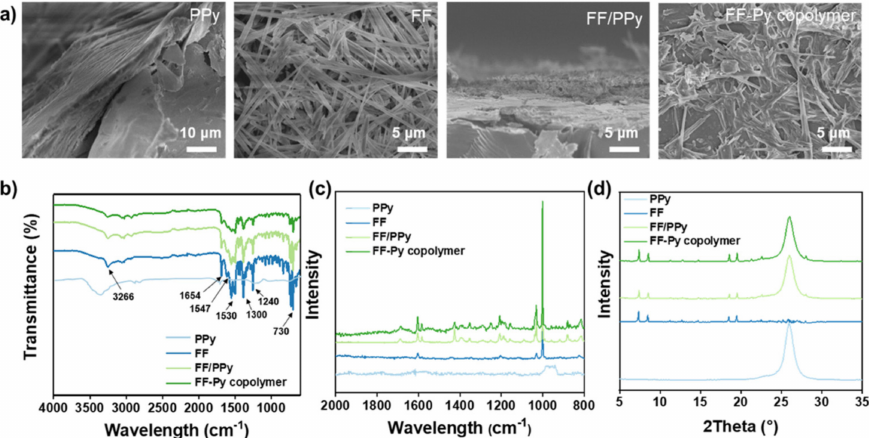
Figure 2. Characterization and electrochemical property of PPy, FF, FF/PPy, and FF–Py copolymer. ( a ) SEM images; ( b ) FTIR spectrum; ( c ) Raman spectrum; ( d ) XRD